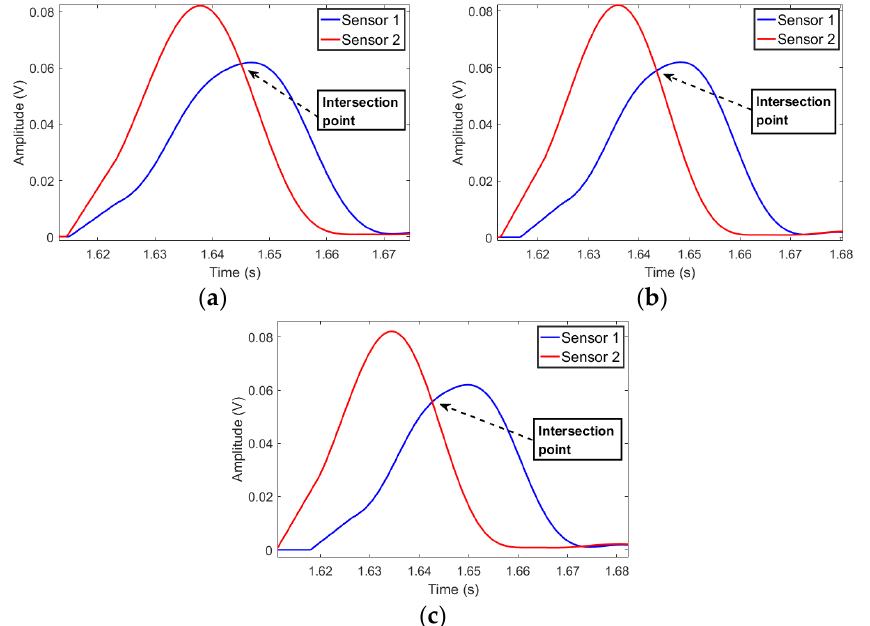
Figure 10. The L2’s time reversed signals, ( a ) 34.71 m, ( b ) 35.21 m, ( c ) 35.71 m.